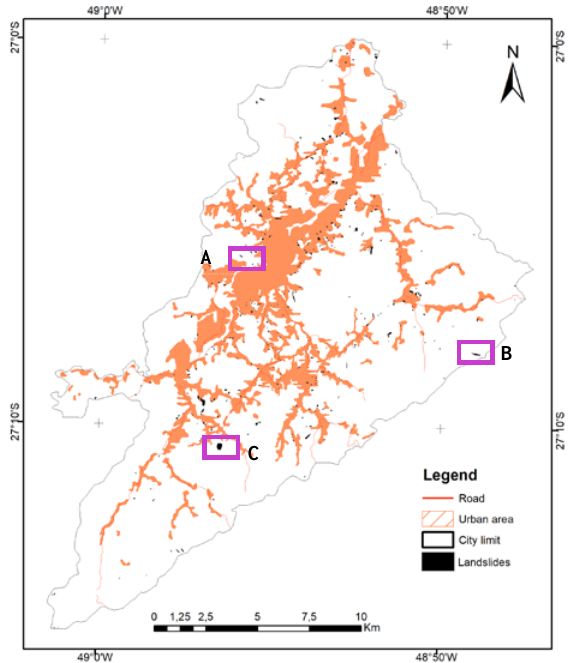
Figure 3. Landslide susceptibility map at 1:50,000 scale, with the location of 33 landslide sites (Modified after CPRM, 2013).